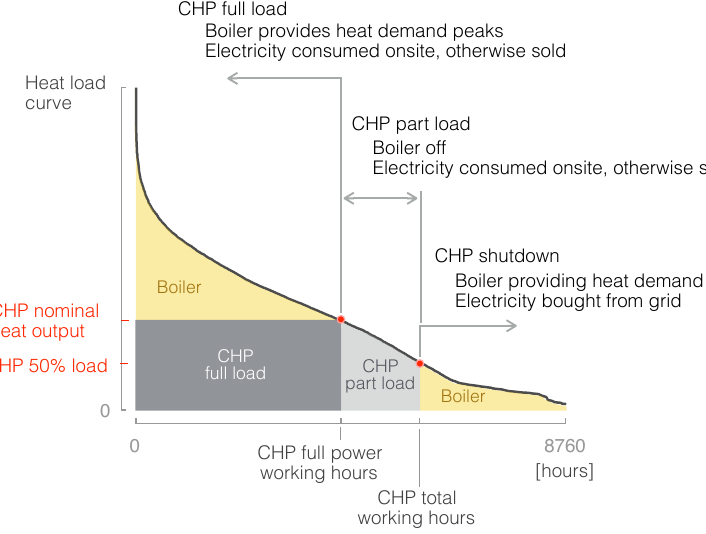
Figure 5. The mGT and the reciprocating ICE units run following the heat demand: the excess or lack of electricity is sold/bought to/from the grid depending on the electricity demand at a given